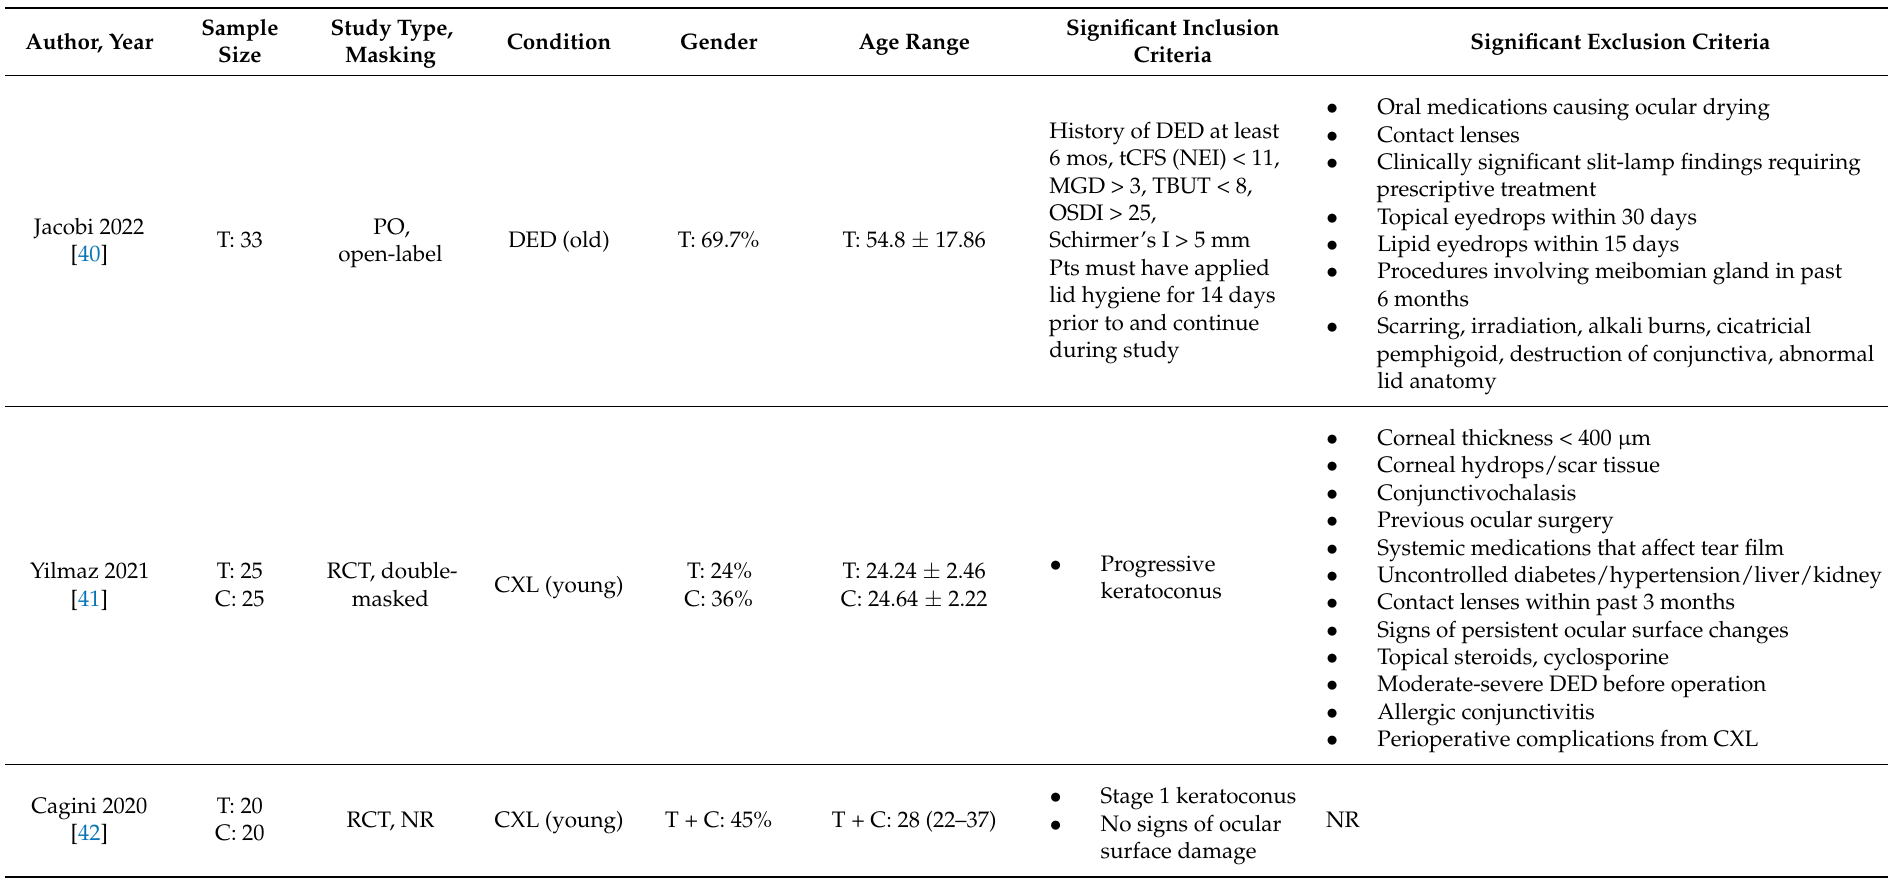
Table 1. Summary of human